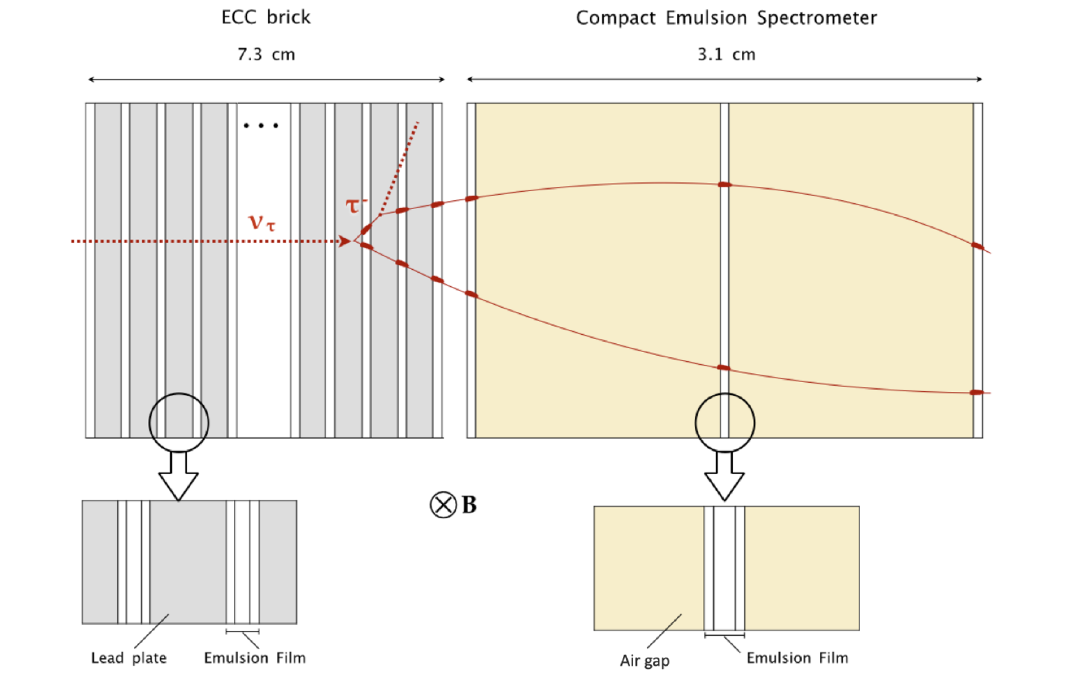
Figure 3. Schematic illustration of the basic unit of the Scattering Neutrino Detector and the ECC brick: on the left, emulsion films interleaved with lead plates; on the right, the Compact Emulsion